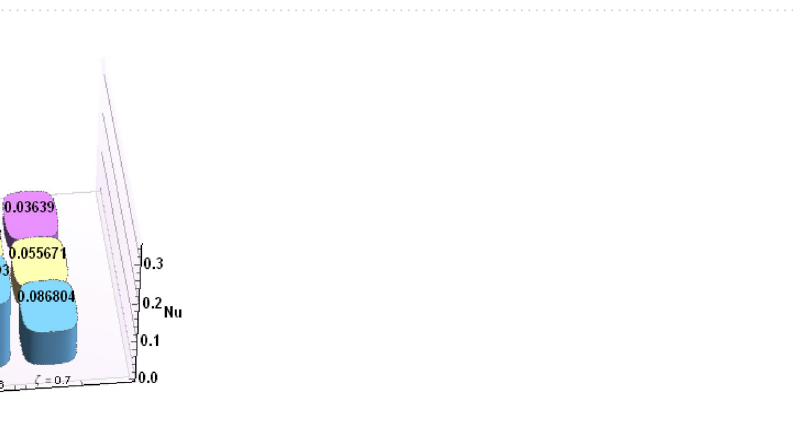
Figure 10. Bar chart representation of Skin friction coefficient and Nusselt number for different parameters using Mathematica 10 software available at (https:// softa sm. com/ wolfr am- mathe matica- 10-4- full- crack/). Nu versus Ec.